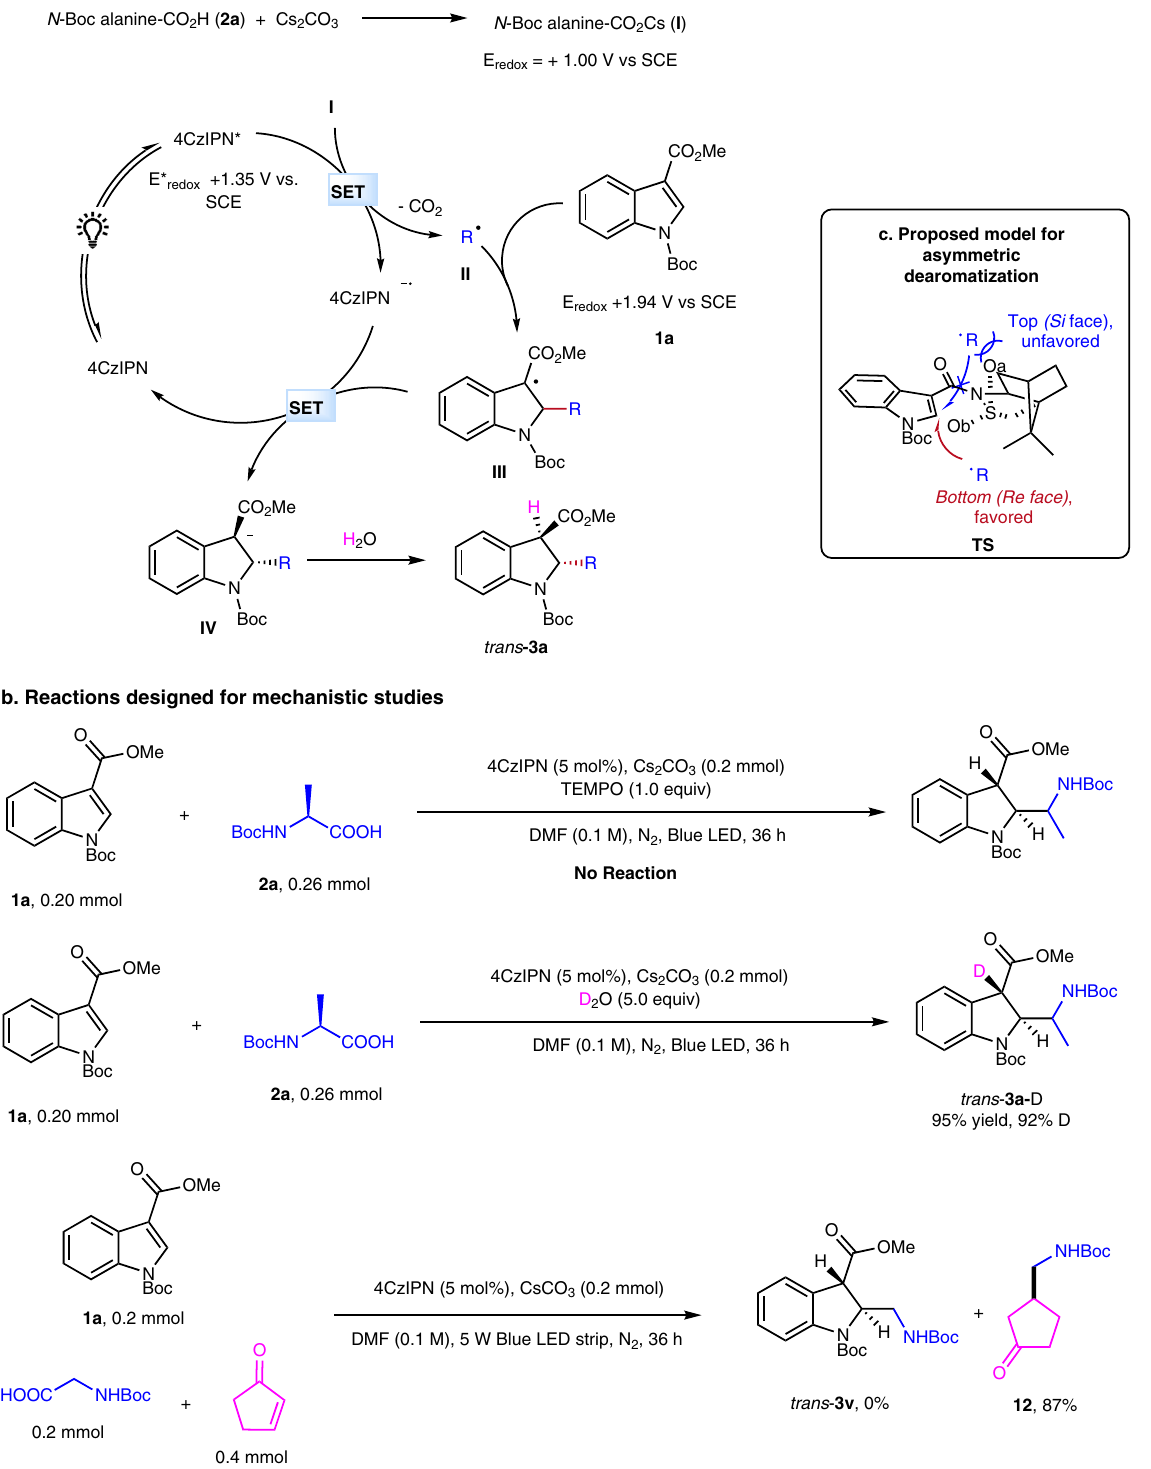
Fig. 6 Proposed reaction mechanism and mechanistic studies. See Supplementary Methods Section 1.9 for the experimental